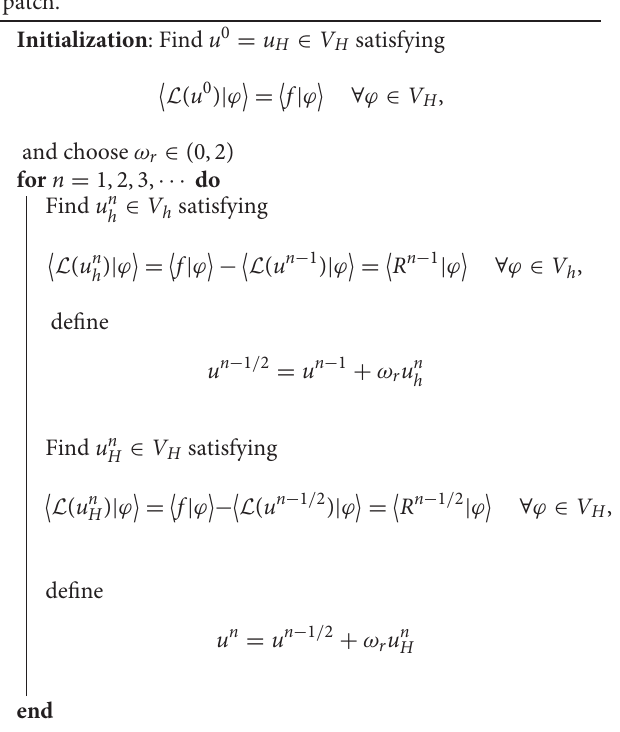
algorithm [37]. The structure of the algorithm is presented in Algorithm (1).